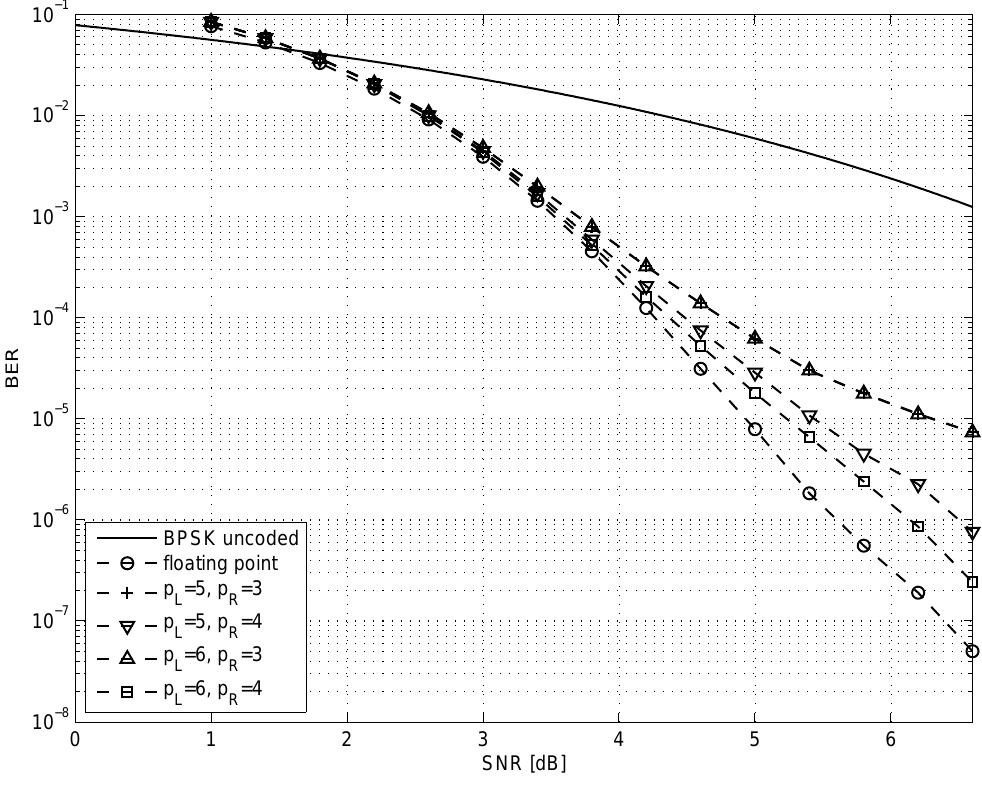
Figure 1. BER performance of the N = 96 LDPC code.